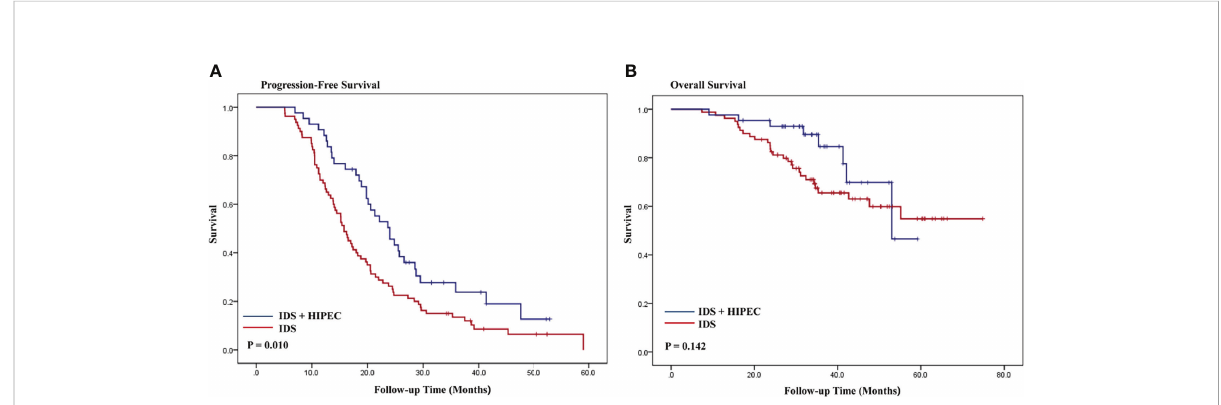
FIGURE 2 Kaplan-Meier curves of progression-free survival and overall survival according to HIPEC in patients with high disease burden (A, B) . IDS, interval debulking surgery.